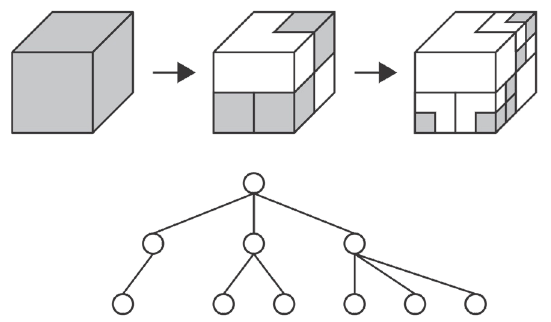
Figure 1 . Top: Spatial subdivisions of an octree up to level 3. Oc- cupied leaf nodes are shaded as grey. Bottom: The corresponding tree structure of the sparse data structure.